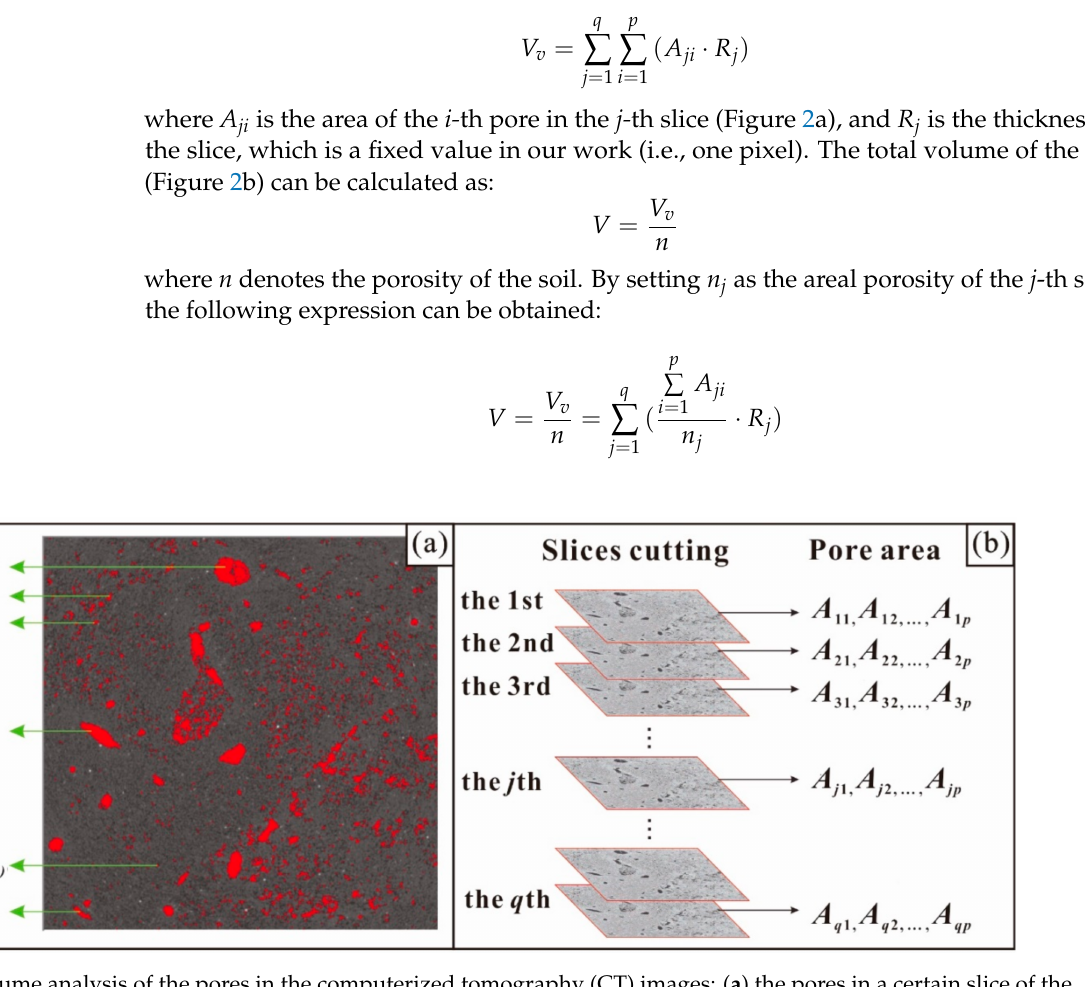
Figure 2. Volume analysis of the pores in the computerized tomography (CT) images: ( a ) the pores in a certain slice of the 3D model, and ( b ) the total volume of pores in all